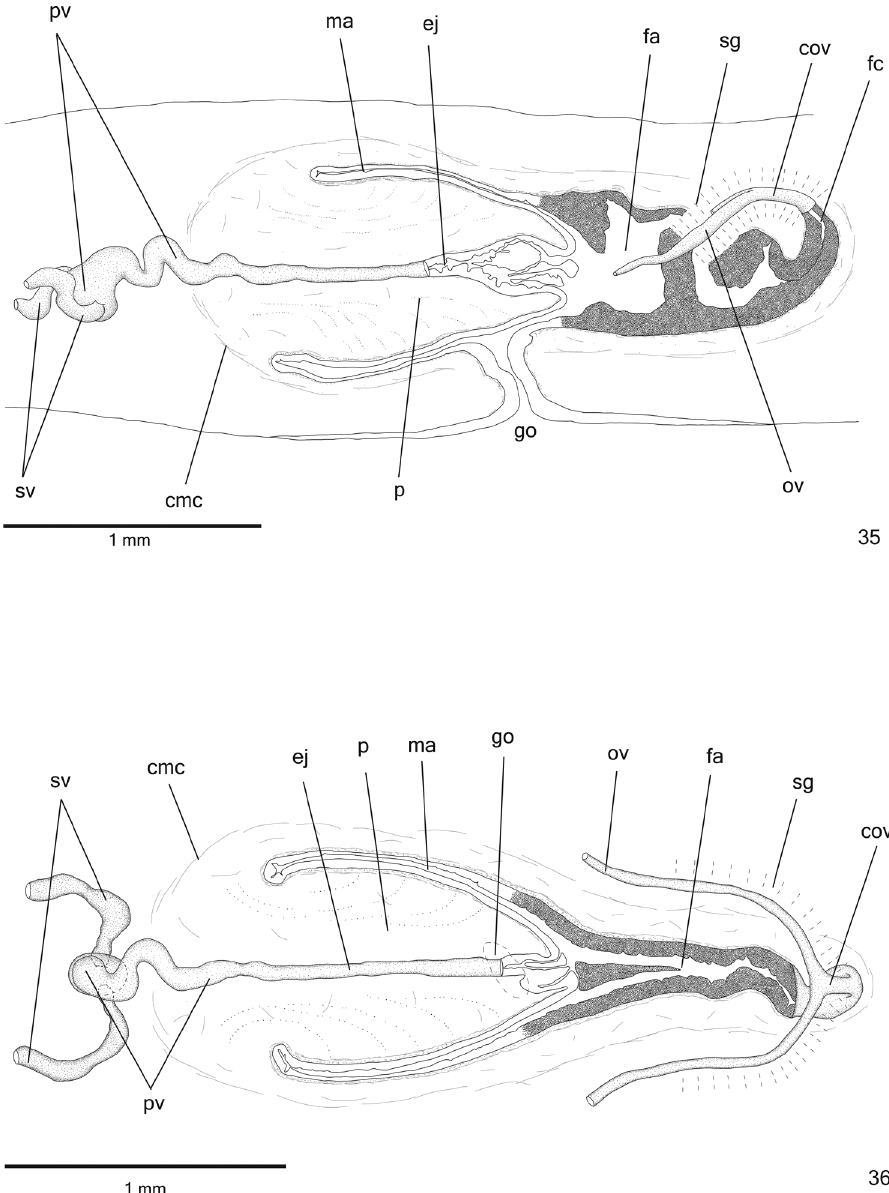
Figures 35–36. Cratera nigrimarginata sp. n., 35 holotype, sagittal composite reconstruction of copula- tory apparatus 36 specimen MZU PL.00221, horizontal composite reconstruction of copulatory apparatus. and atrium composed of interwoven circular and longitudinal fibres. Specimen MZU PL.00220 shows poorly developed vitelline follicles, but copulatory organs, including shell glands, fully